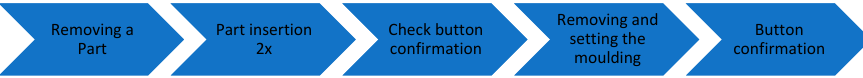
Figure 2. Workflow diagram.